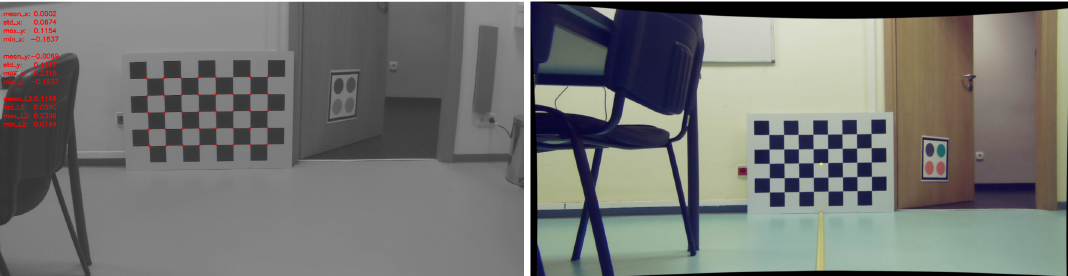
Figure 5. Calibration of camera using Kalibr. On the left—snapshot of the chessboard pattern with the characteristic corner points found. On the right—image from the calibrated camera, rectified using the computed calibration data.